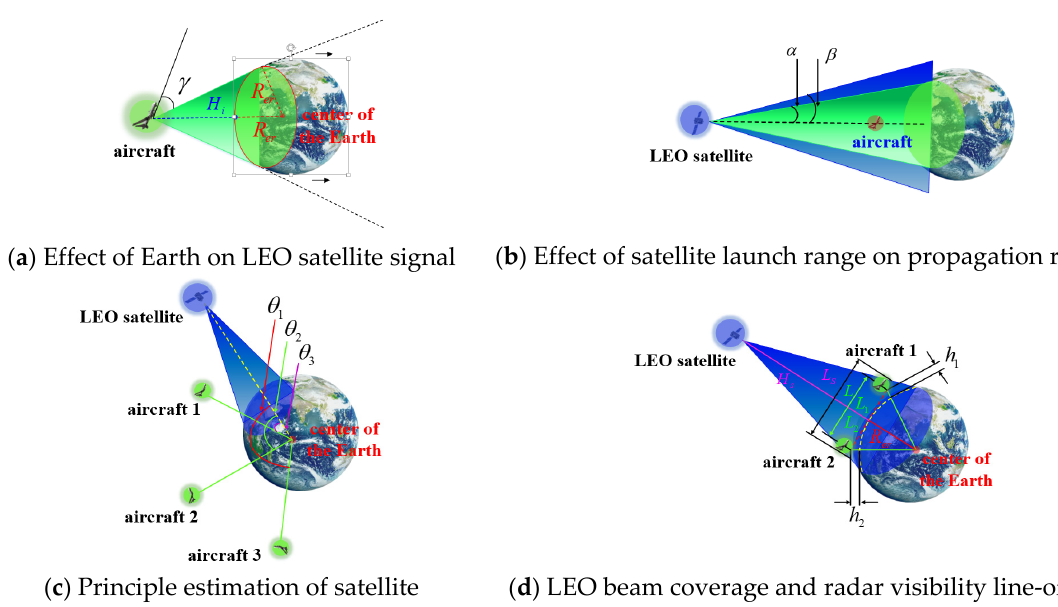
Figure 5. Schematic diagram of the effect of aircraft spacing range on satellite